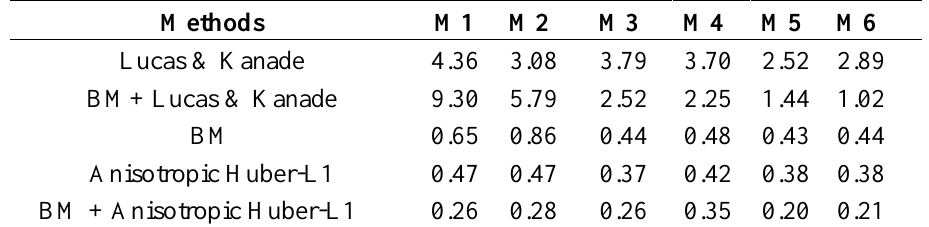
Table A4. Diameter error results after being evaluated with different